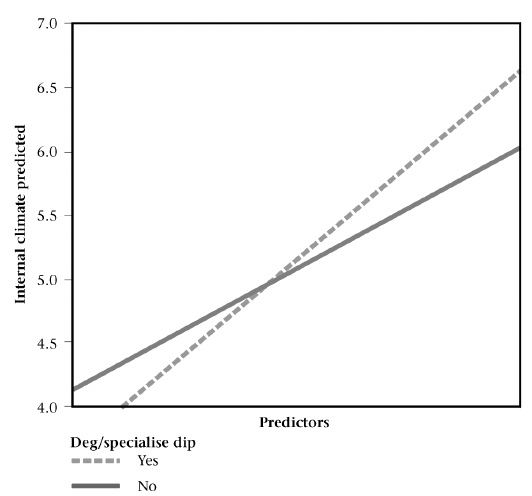
Figure 3: Predictors of Internal